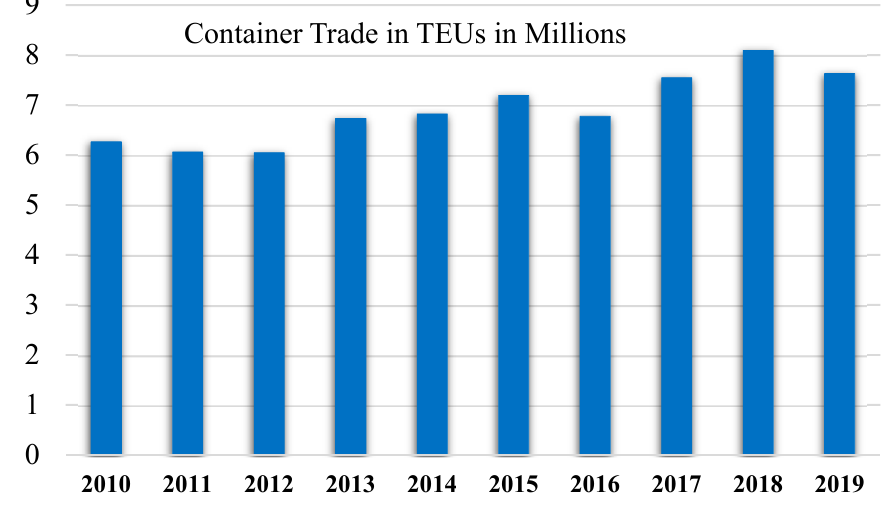
Figure 2. Container trades in TEUs.